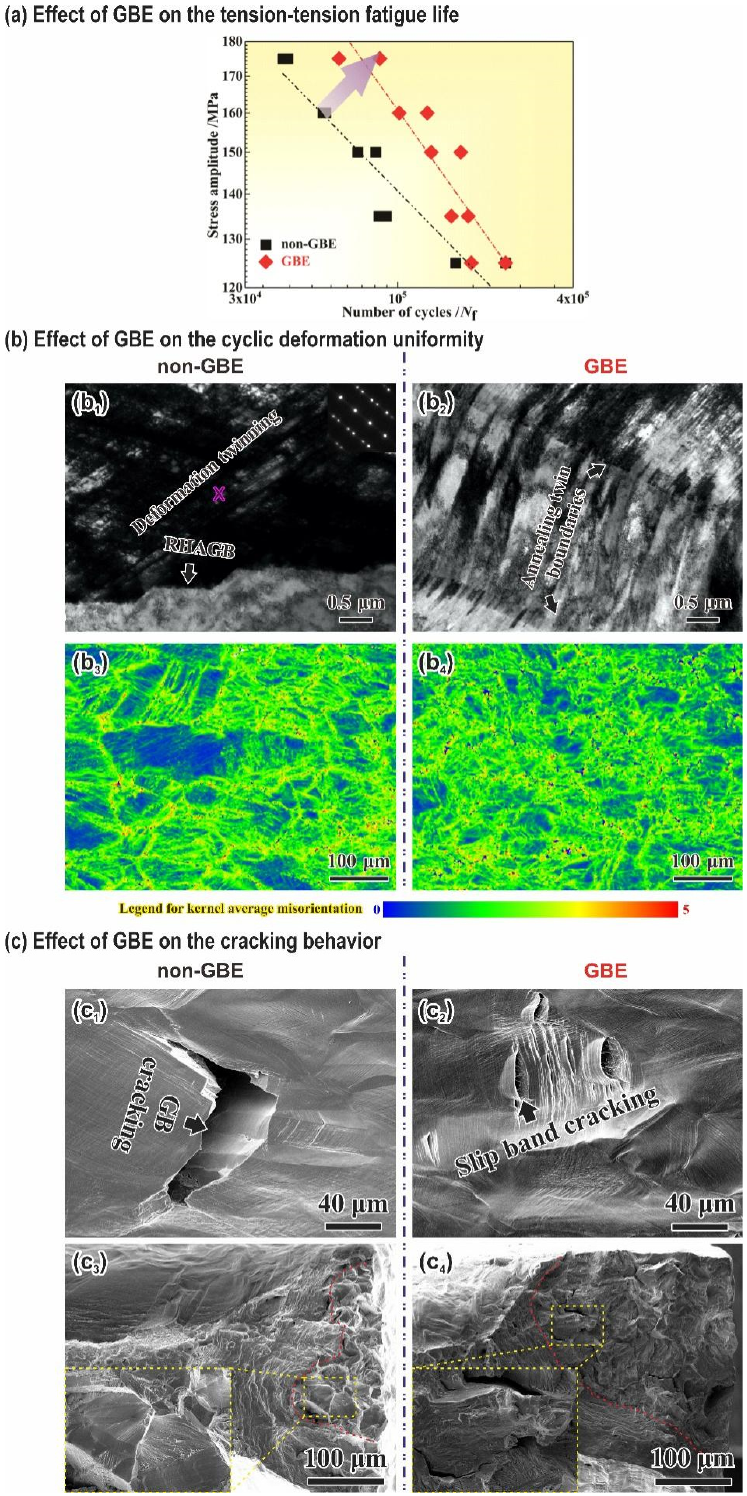
Figure 8. Effect of GBE on the Fatigue Performance of Cu-16at.% Al Alloy. ( a ) Comparison of the fatigue lives of non-GBE and GBE samples at different stress amplitudes; and comparisons of the deformation uniformity ( b ) and cracking behavior ( c ) of non-GBE and GBE samples fatigued at a stress amplitude of 175 MPa. adopted from Ref. [13]